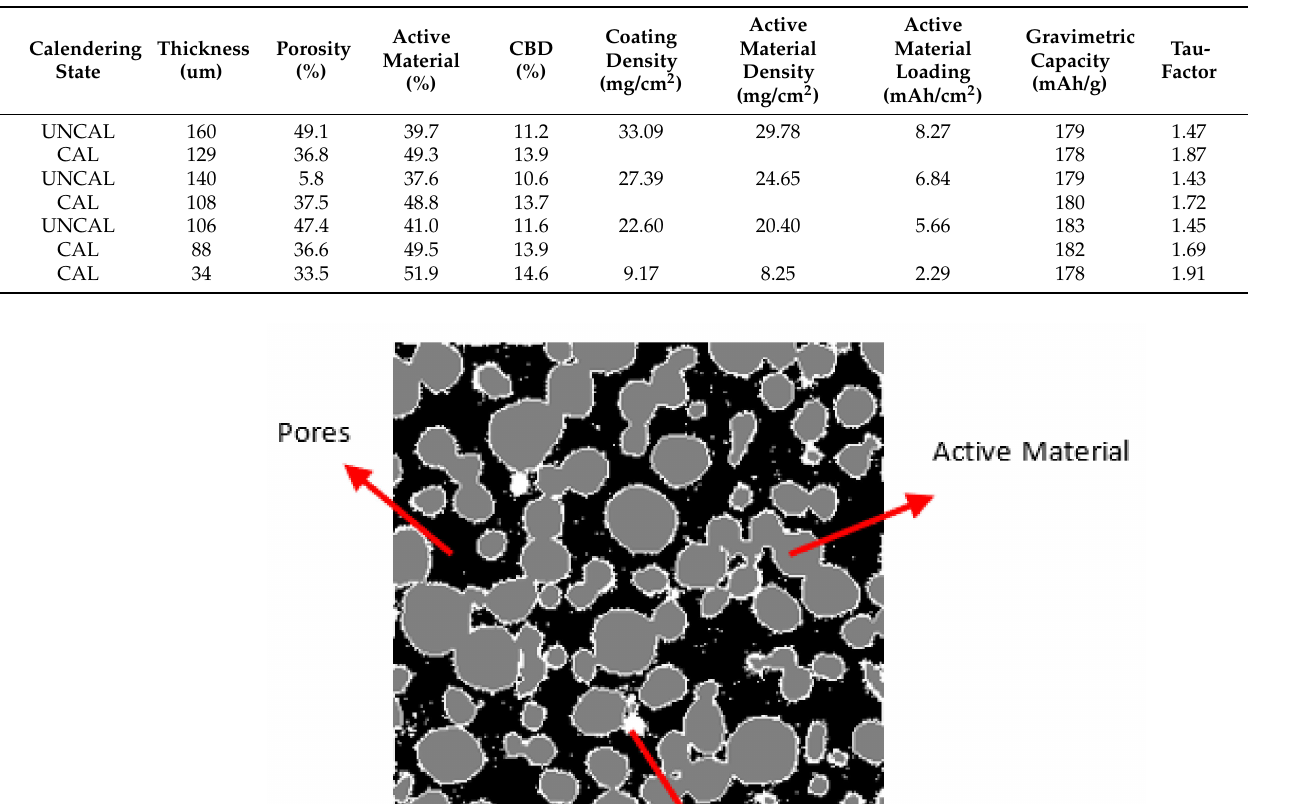
Table 1. The characteristics of the cathode microstructures.